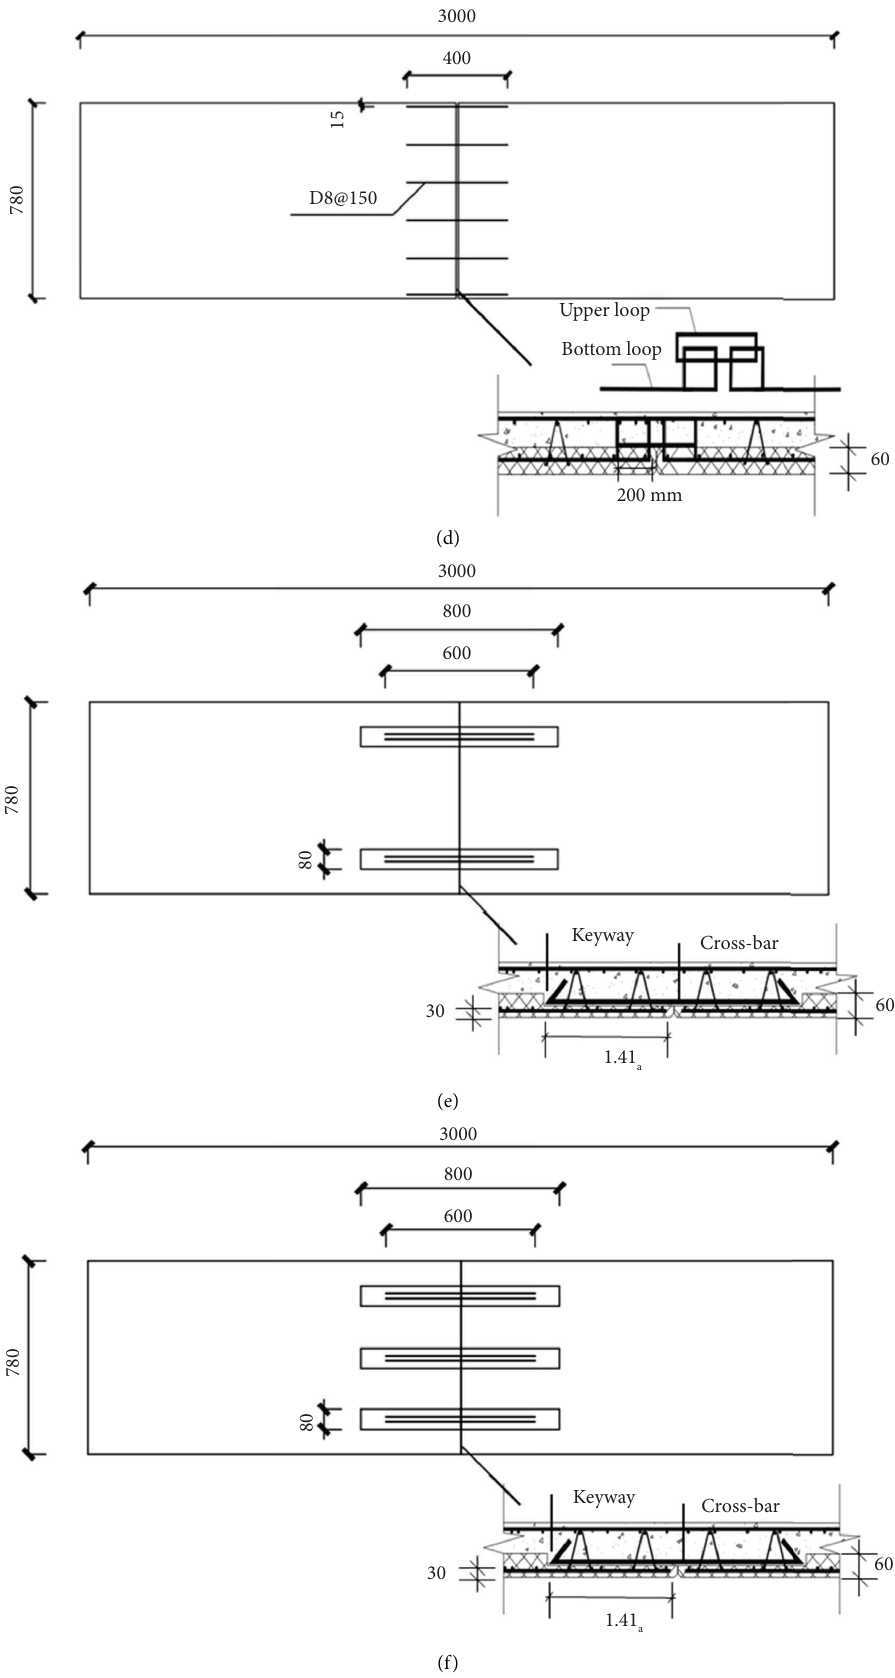
Figure 4: Diferent connection confgurations in specimens. (a) LGS02. (b) LGSA1. (c) LGSA2. (d) LGSB1. (e) LGSB2. (f)